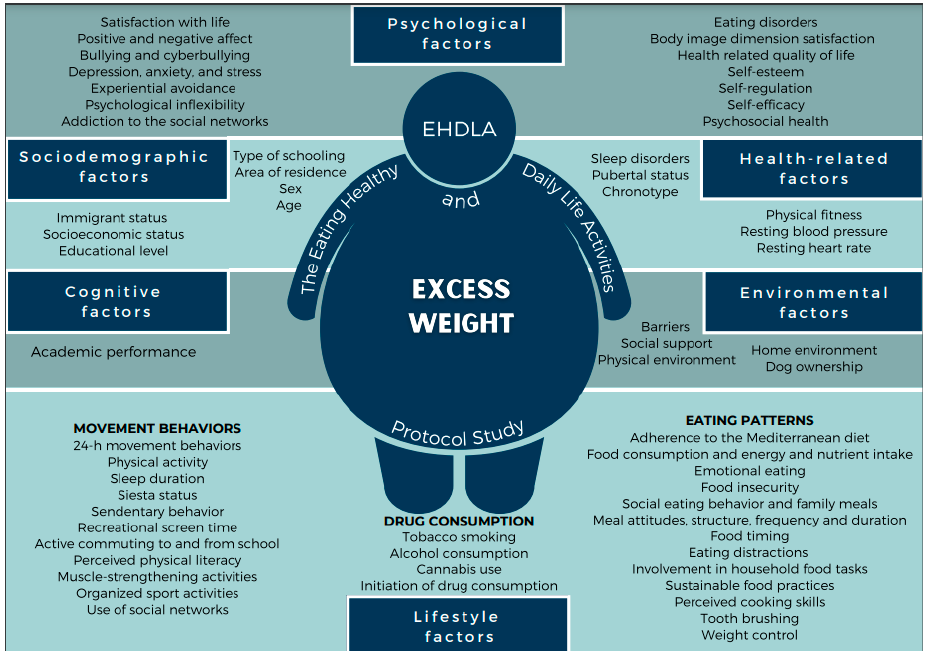
Figure 1. Variables analyzed in the Eating Healthy and Daily Life Activities Study.